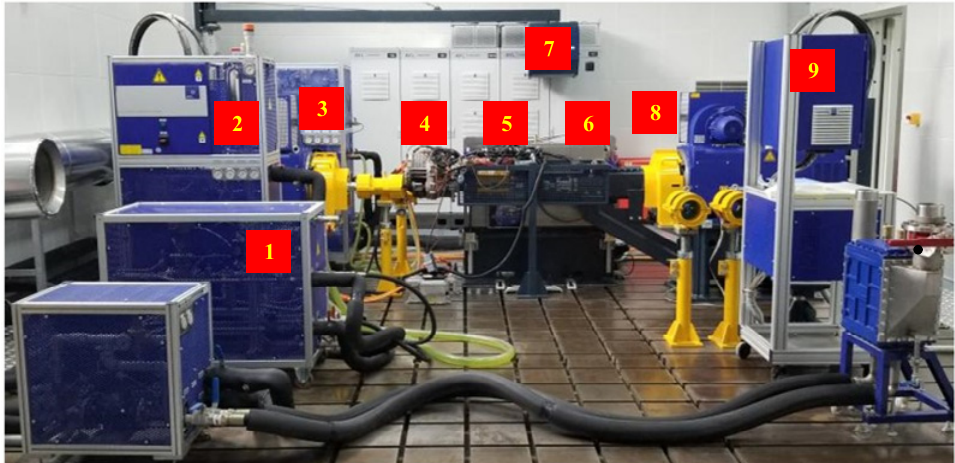
Figure 14. Test bench: 1. Oil cooling system; 2. motor cooling system; 3. variable frequency motor; 4. driving motor and coupling mechanism; 5. HMT; 6. central transmission device; 7. power cabinet of dynamometer; 8. electrical dynamometer; 9. data acquisition cabinet.